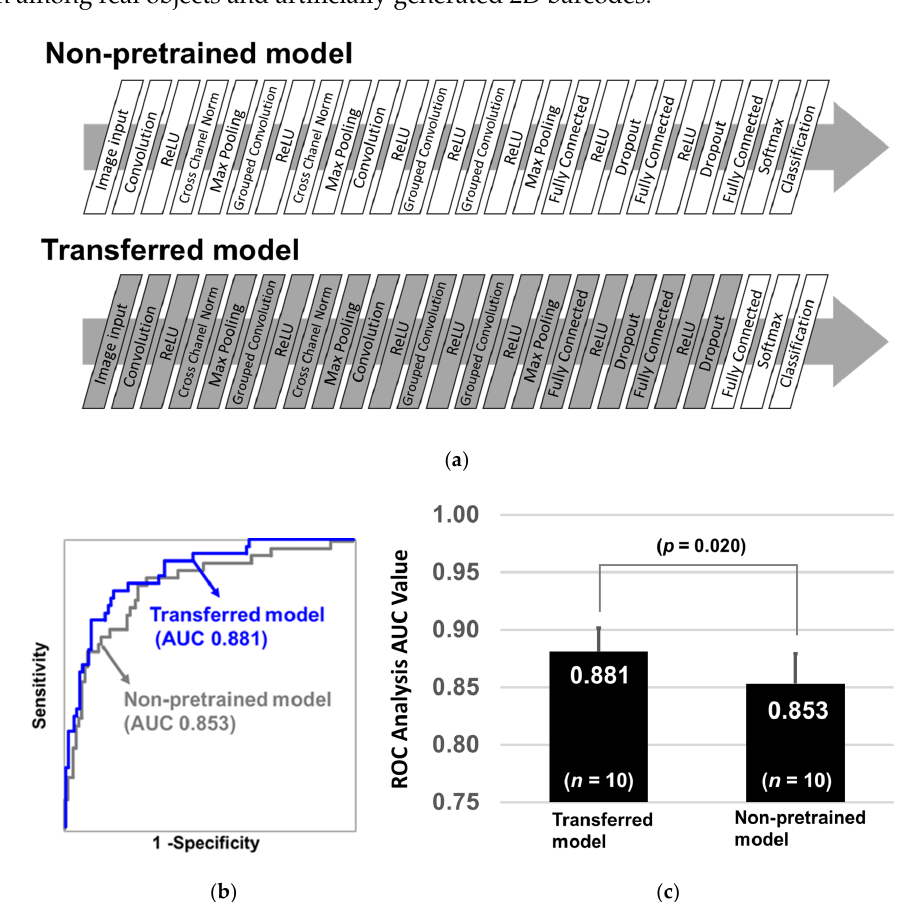
Figure 1. Diagnostic performance of non-pretrained and transferred AlexNet models. ( a ) Diagnostic performance (AUC (area under curve) of ROC (receiver operating characteristic)) of the non-pretrained and transferred AlexNet convolutional neural network (CNN) models was compared. The non-pretrained model was established by an original AlexNet framework with 25 fresh layers whose parameters were not optimized (Non-pretrained model). The composition of the transferred AlexNet model was the same as that of the non-pretrained model, but the parameters were already trained with the help of more than one million images from the ImageNet database; further, only last three layers were initialized (Transferred model). ( b ) White layer: non-trained, Gray layer: pretrained. After the two models were trained with 60% of the 351 samples, they were evaluated by the remaining 40% samples. ROC curves were shown with blue line (transferred) and gray line (non-pretrained). ( c ) This process was repeated 10 times and the p -values of the Wilcoxon rank sum test were calculated between two